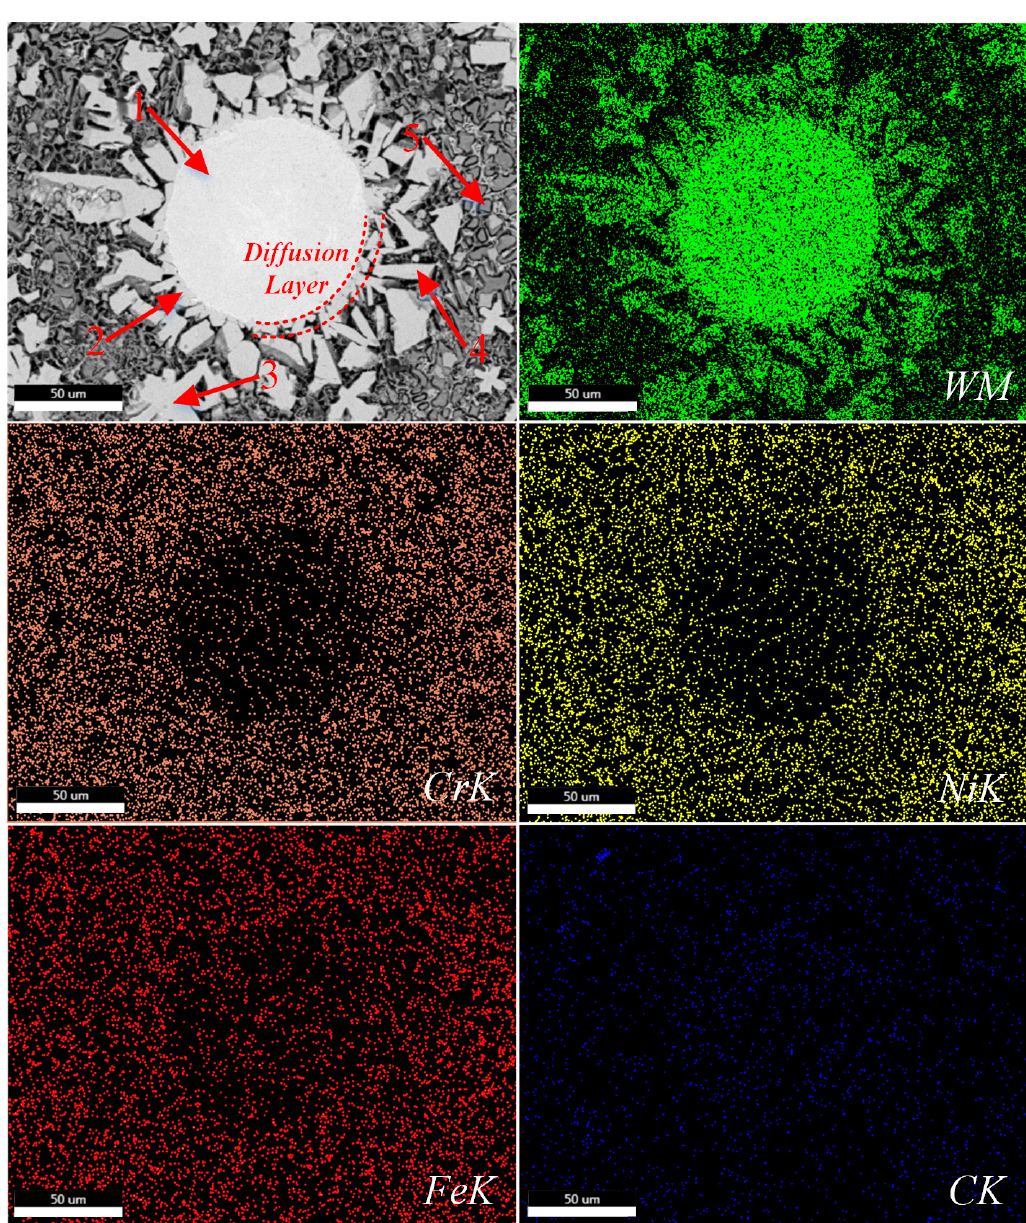
Figure 7. EDS map scanning results of typical microstructure in composite coatings. Table 4. Chemical compositions of different phases in the composite coating.